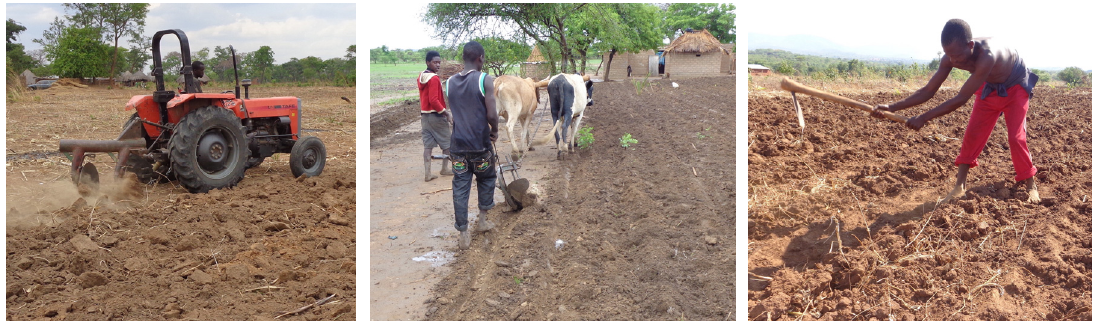
Figure 10. Conventional tillage: tractor disc ploughing, shallow ox ploughing, and hand-hoe ridging (photo: K.B. Esser).